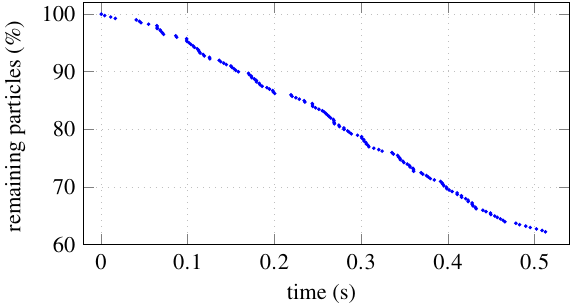
FIG. 19. Relative particle loss with bunch length jitter as a function of time. The initial sample contains 400 particles randomly distributed according to Table